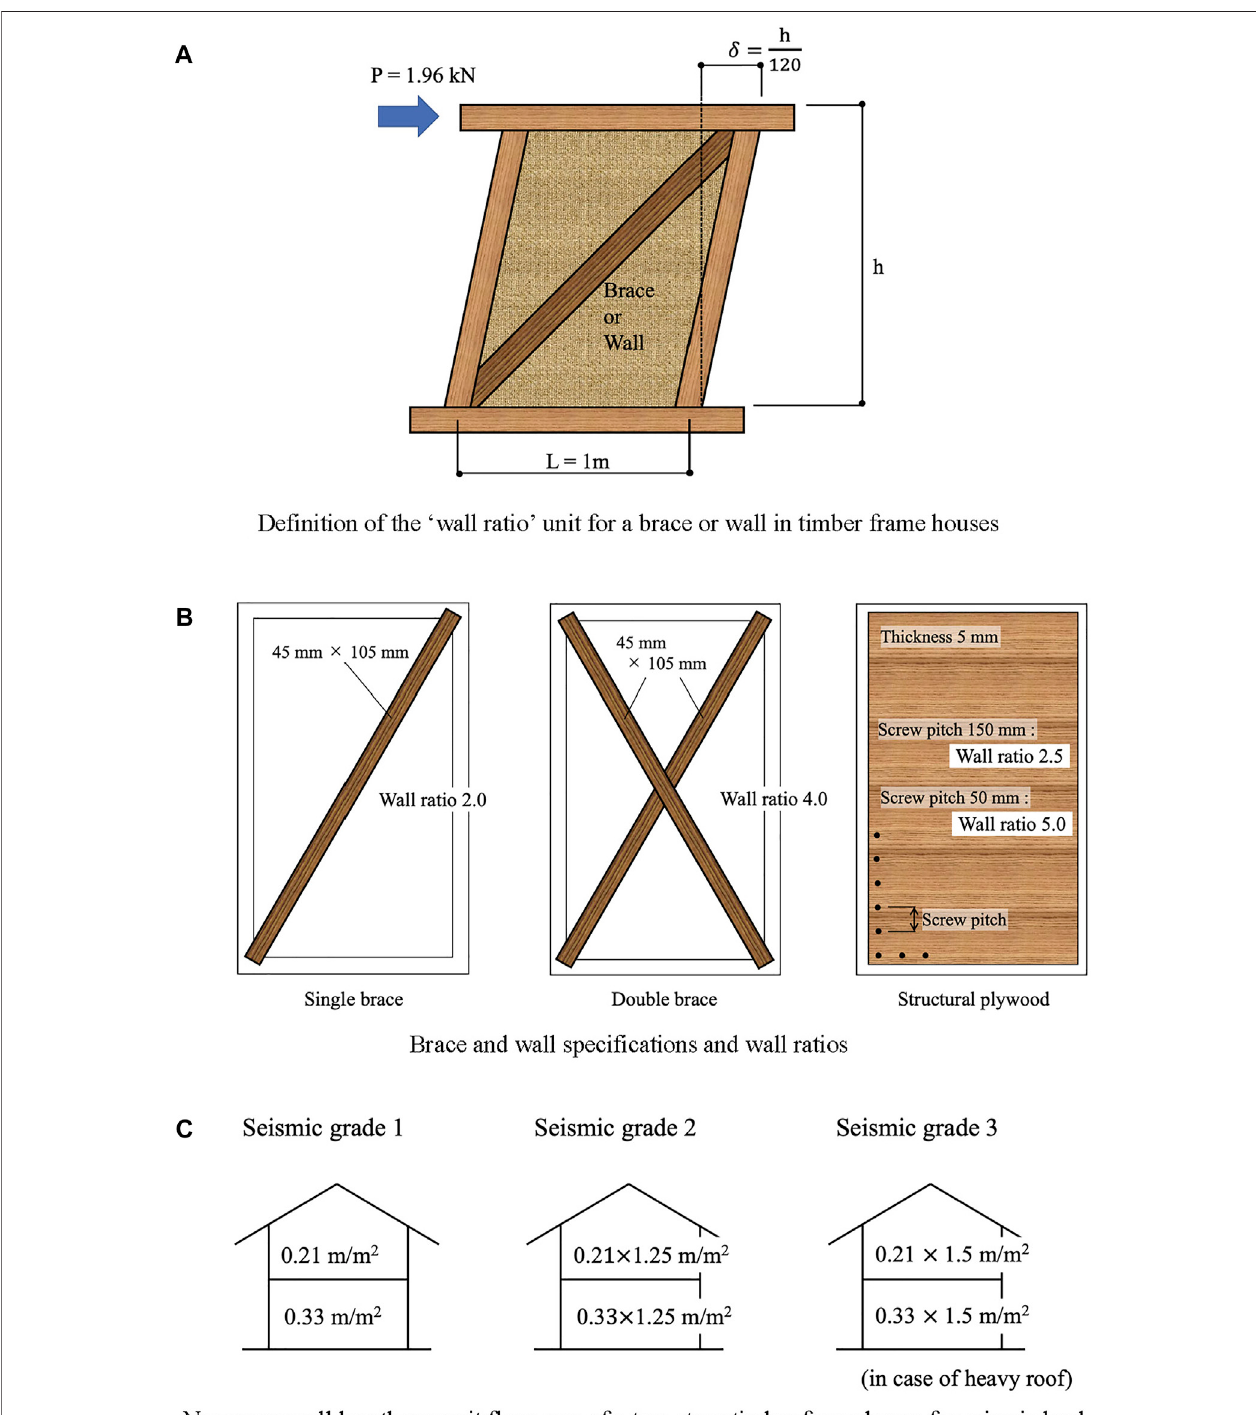
FIGURE5| Wallratioandnecessarywalllengthoftimberframehouses. (A) De fi nitionofthe ‘ wallratio ’ unitforabraceorwallintimberframehouses. (B) Braceand wall speci fi cations and wall ratios. (C) Necessary wall length per unit fl oor area of a two-story timber frame house for seismic load.